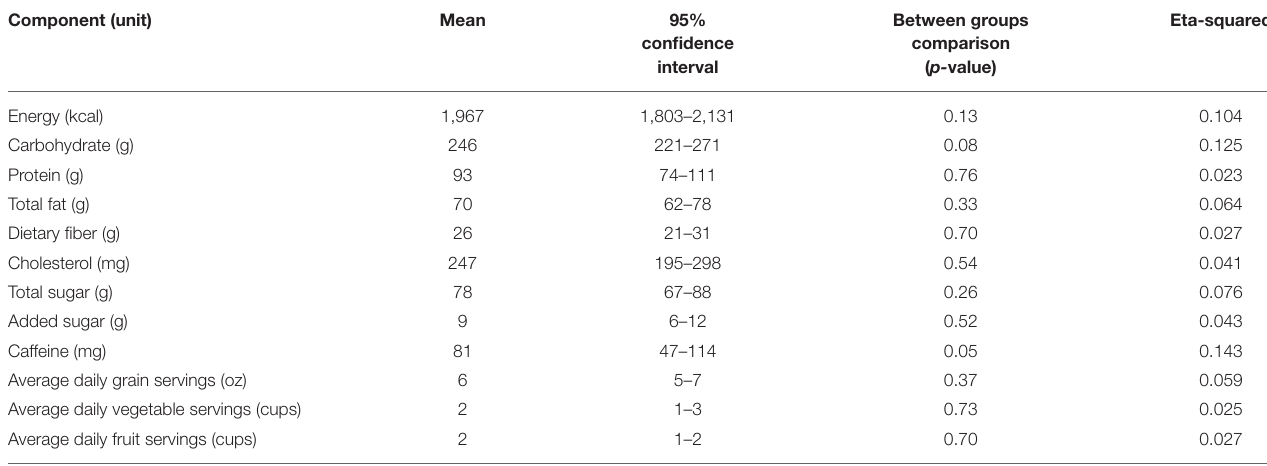
TABLE 2 | Mean daily energy, alcohol, and nutrient intake of participants ( n = 51) in the 3-day food log. Component (unit) Mean